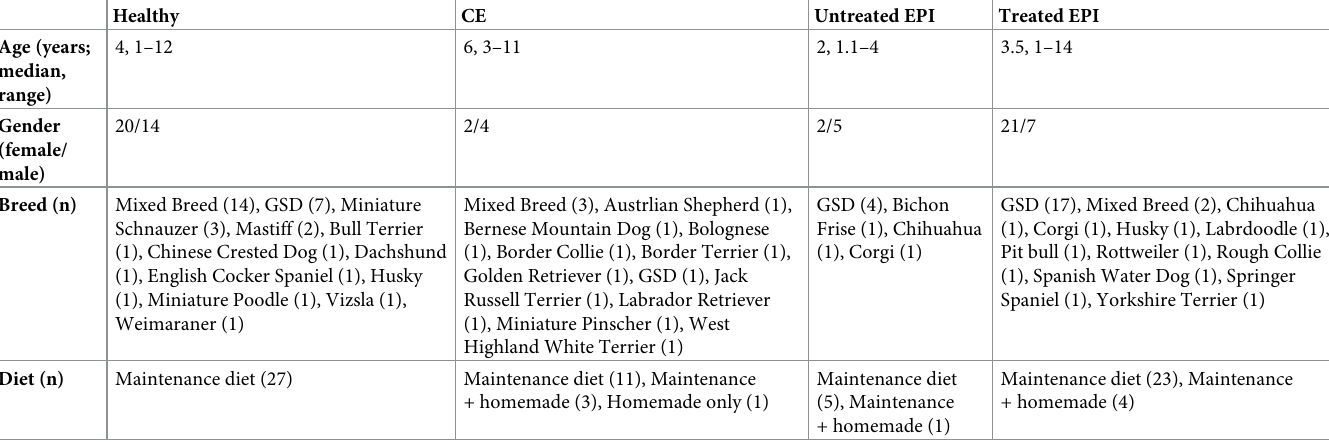
Table 1. Metadata for dogs included in the study, if available. Healthy